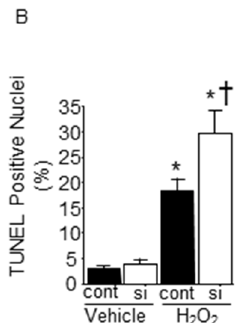
Figure 6. Evaluation of apoptosis induced by H 2 O 2 stimulation in vitro : ( A ) representative TUNEL stained sections from SMP30 siRNA and control siRNA cardiomyocytes subjected to 24 h of H 2 O 2 stimulation; ( B ) percentages of TUNEL-positive nuclei in sections. Data are represented as mean ± SE ( n = 6), Scale bars: 200 μ m, * p < 0.05 vs. vehicle control siRNA, and † p < 0.05 vs. H 2 O 2 control siRNA.